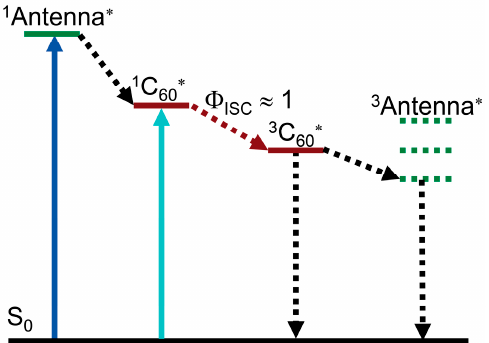
Figure 12. Mechanism for using of C 60 as an electron spin converter to prepare heavy atom-free triplet PSs (antenna-C 60 dyads). * stands for the excited state.